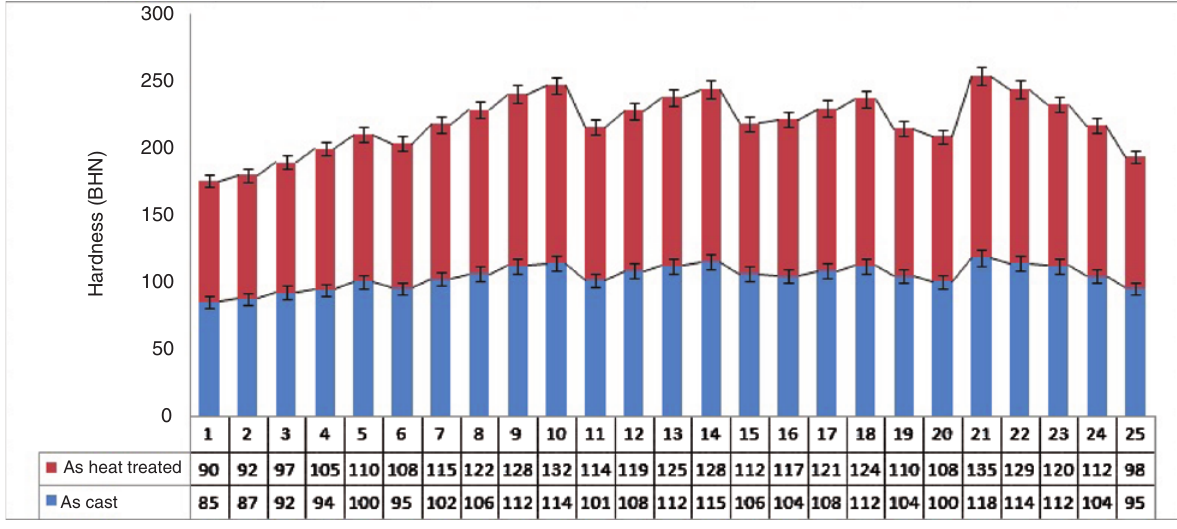
Figure 4: Hardness of hybrid green